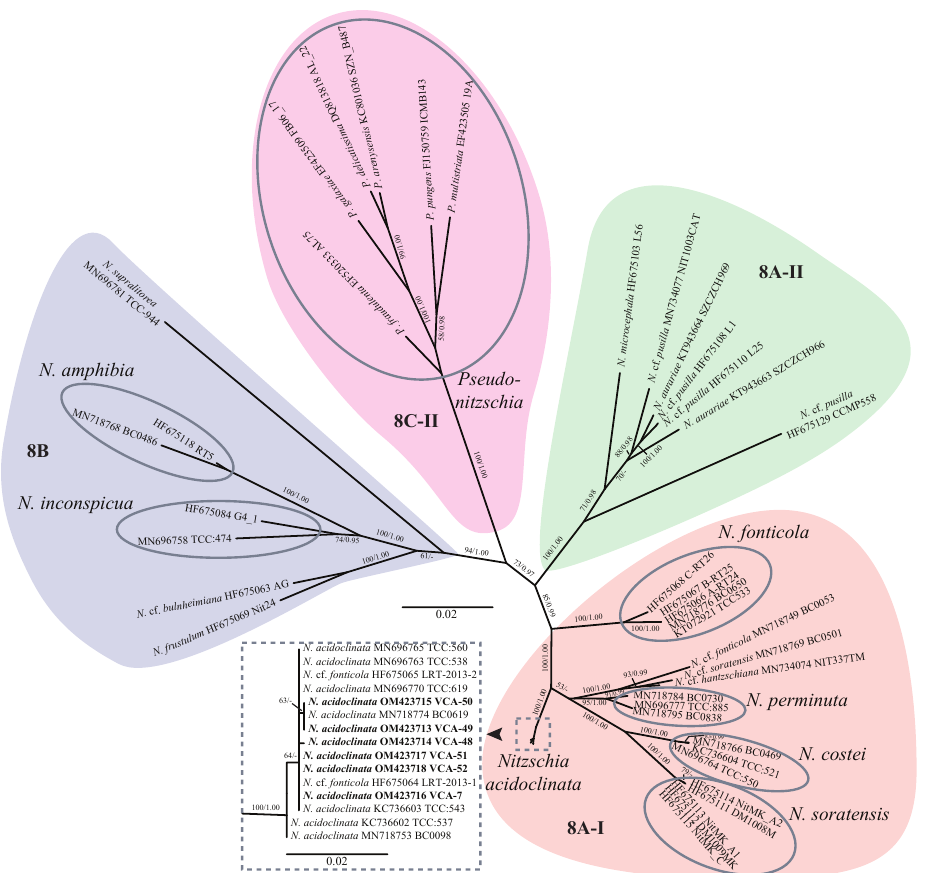
Figure 2. Unrooted ML tree showing the phylogenetic position of the new strains of N. acido- clinata based on plastid-encoded rbc L gene sequence data (GTR+I+G model). Support [ML/BI, (BP) ≥ 50% and (PP) ≥ 0.95] are given above/below the branches. Sequences obtained for this study are shown in boldface. Clade designations follow Mann et al. [19]. Scale bars—substitutions per nucleotide